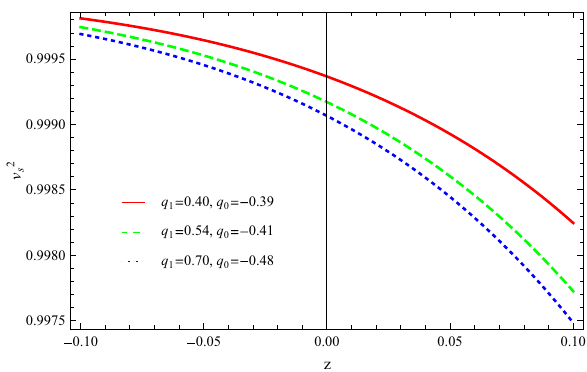
Fig. 6 Plot of v 2 s versus z at Hubble horizon with Bekenstein entropy